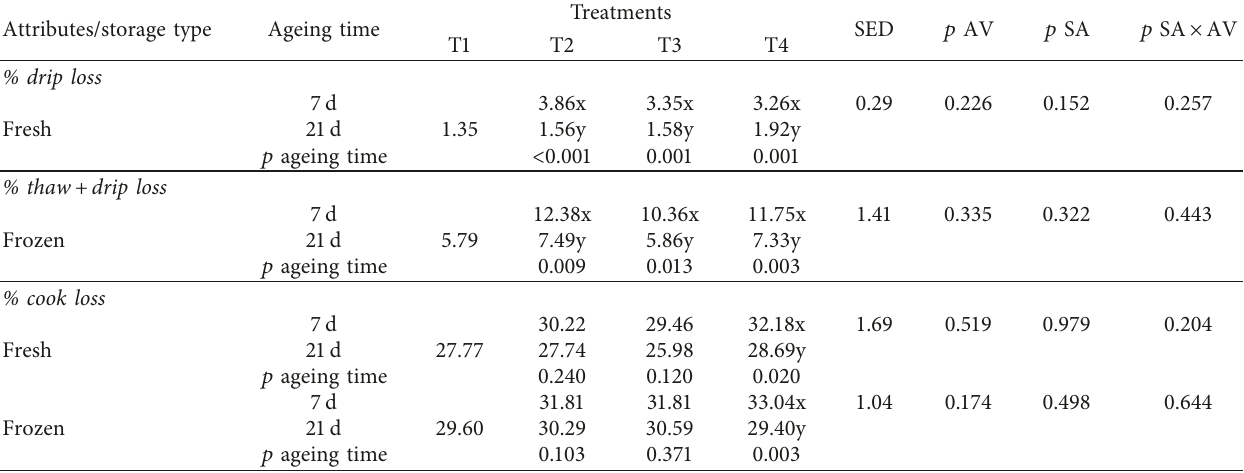
Table 4: Effect of ageing treatments, ageing time, and frozen storage on water-holding capacity of in-bag dry-aged lean bull beef. Attributes/storage type